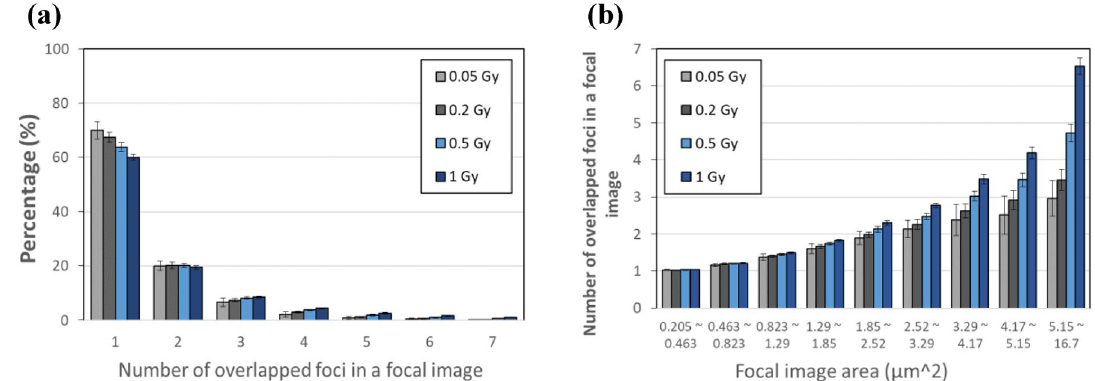
Figure 7. The multiplicity distribution of γ-H2AX foci in a single focal image induced at 0.05, 0.2, 0.5 and 1 Gy of alpha particle exposure: ( a ) the percentage of focal images that consist of multiple overlapped foci, ( b ) the average number of overlapping foci in a focal image of different